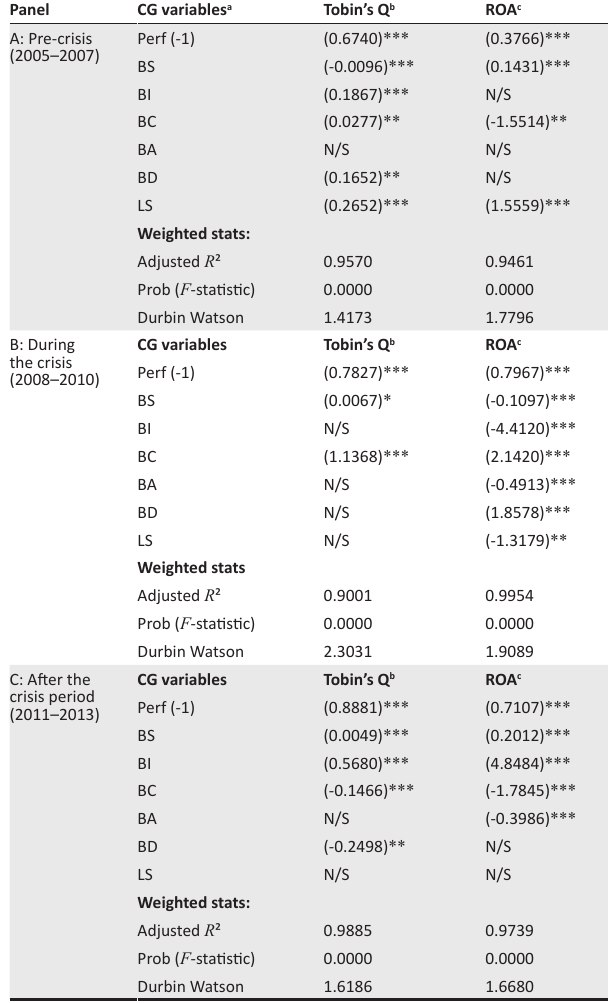
TABLE 5: Regression results of the impact of corporate governance attributes on Tobin’s Q and Return on Asset for the industrials industry.